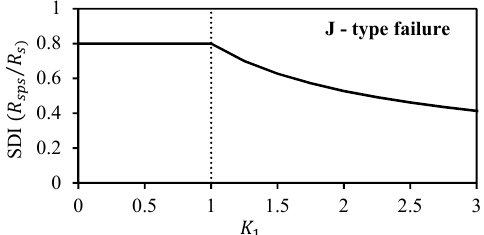
Figure 18. SD index corresponding to J-Failure